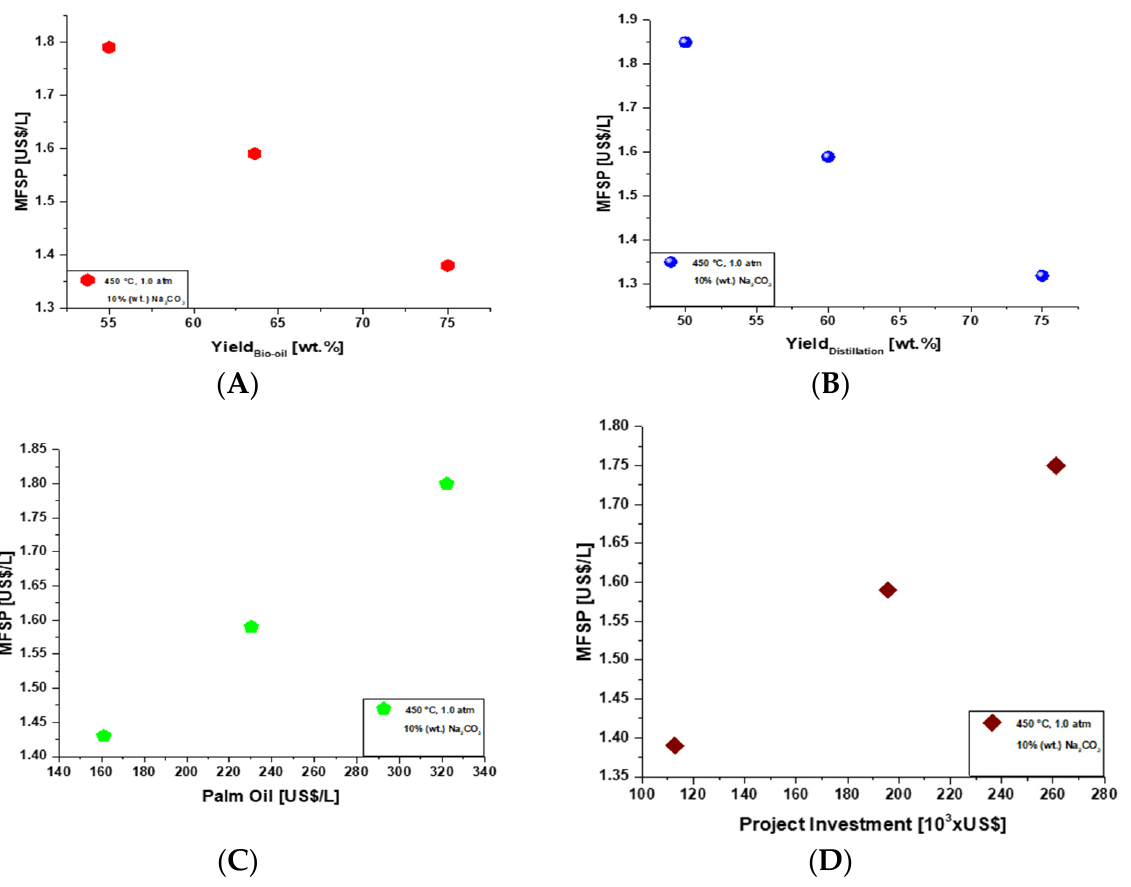
Figure 4. ( A )—MFSP as a function of bio-oil yield by sensitivity analysis for a 900 L/day production. ( B )—MFSP as a function of distillation yield by sensitivity analysis for a 900 L/day production. ( C )—MFSP as a function of cost of crude palm oil by sensitivity analysis for a 900 L/day production. ( D )—MFSP as a function of project investment by sensitivity analysis for a 900 L/day production.